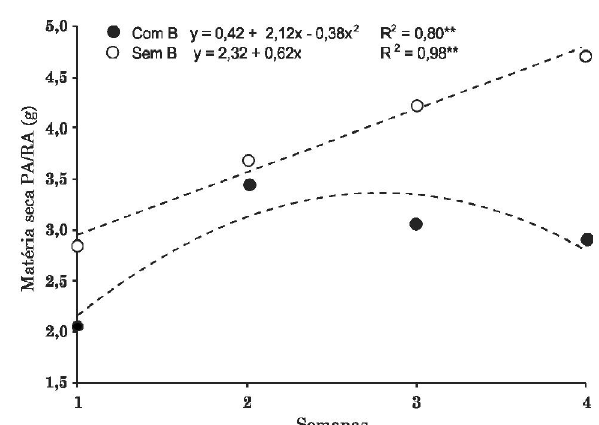
Figura 2. Relação entre a produção de matéria seca da parte aérea e raiz de algodoeiro, em função de doses de B e do tempo de exposição à deficiência (média de quatro cultivares). ** indica significância (p<0,01).